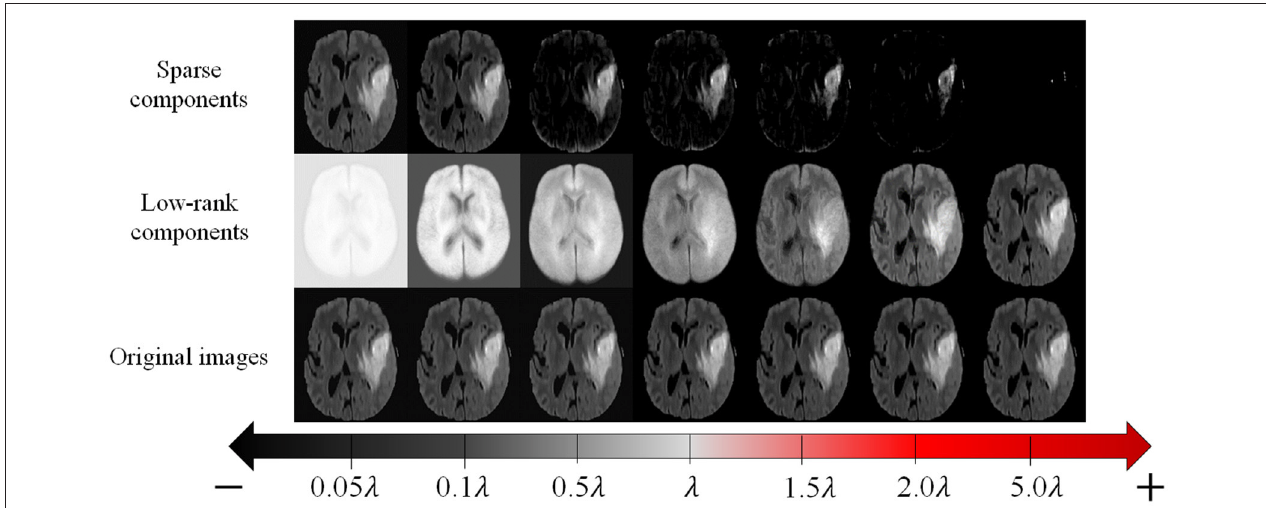
FIGURE 3 | The original MR images (bottom row) , and corresponding recovered low-rank components (middle row) and sparse components (top row) given by conventional LSD method, with different values of regularizing parameter λ .